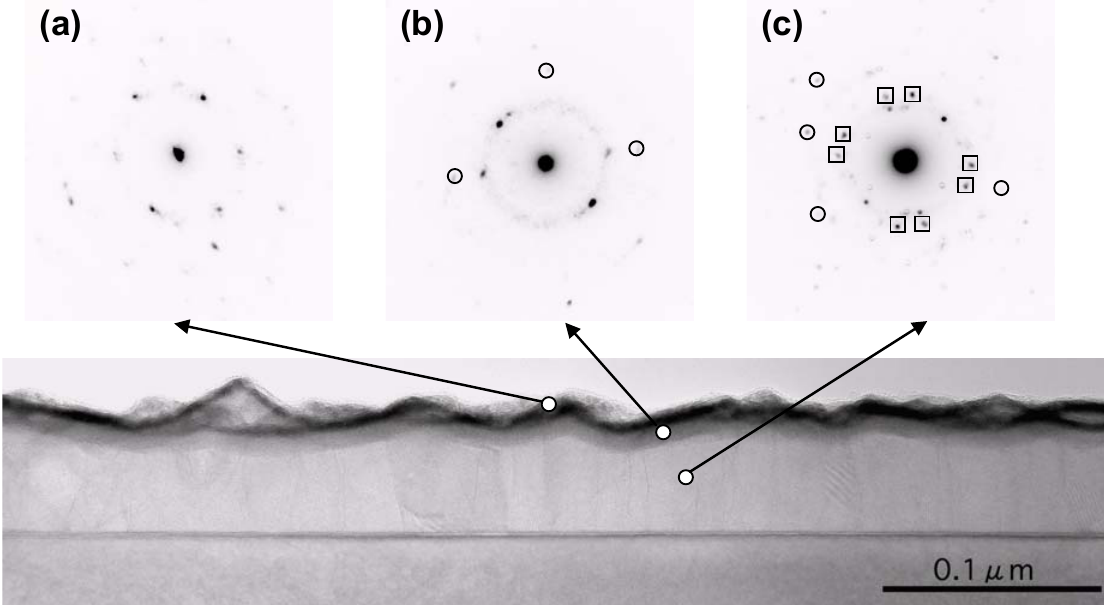
Figure 2. Cross-sectional image of as-deposited Pd capped Mg thin film with micro-diffraction patterns observed by